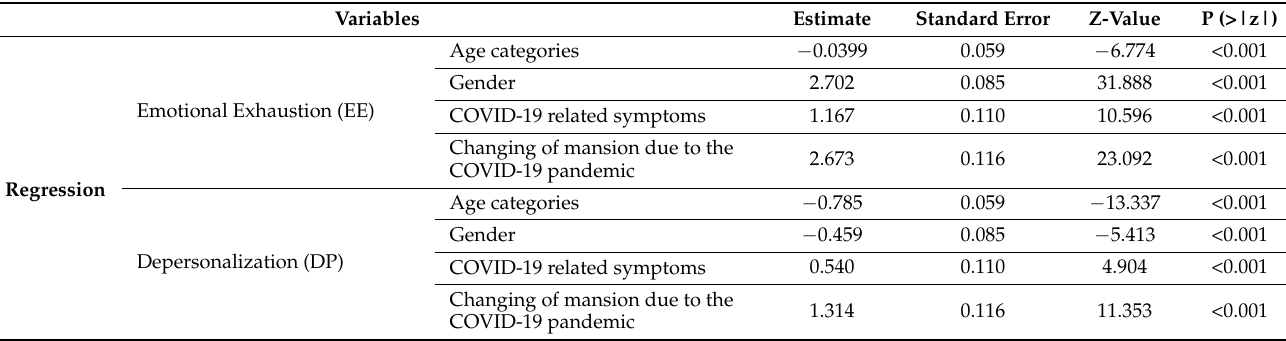
Table 5. Regression and covariance, intercept of Emotional Exhaustion (EE), Depersonalization (DP), Personal Accomplish- ment (PA), Beck Depression Inventory (BDI), Beck Anxiety Inventory (BAI), Impact of Event Scale (IES) and General Health Questionnaire 12 Items